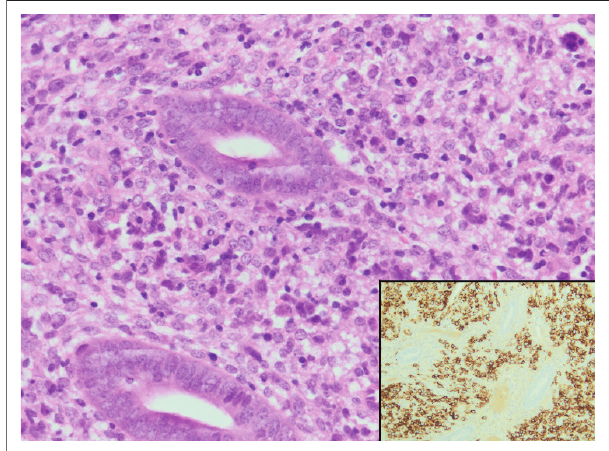
FIGURE 3: Diffuse large B-cell non-Hodgkin lymphoma infiltrating endometrial stroma in a sample from a 22-year-old patient with lymphadenopathy and organomegaly (original magnification ×400). CD20 immunohistochemical stain showing CD20-positive B-cells stained brown (inset, original magnification ×200).